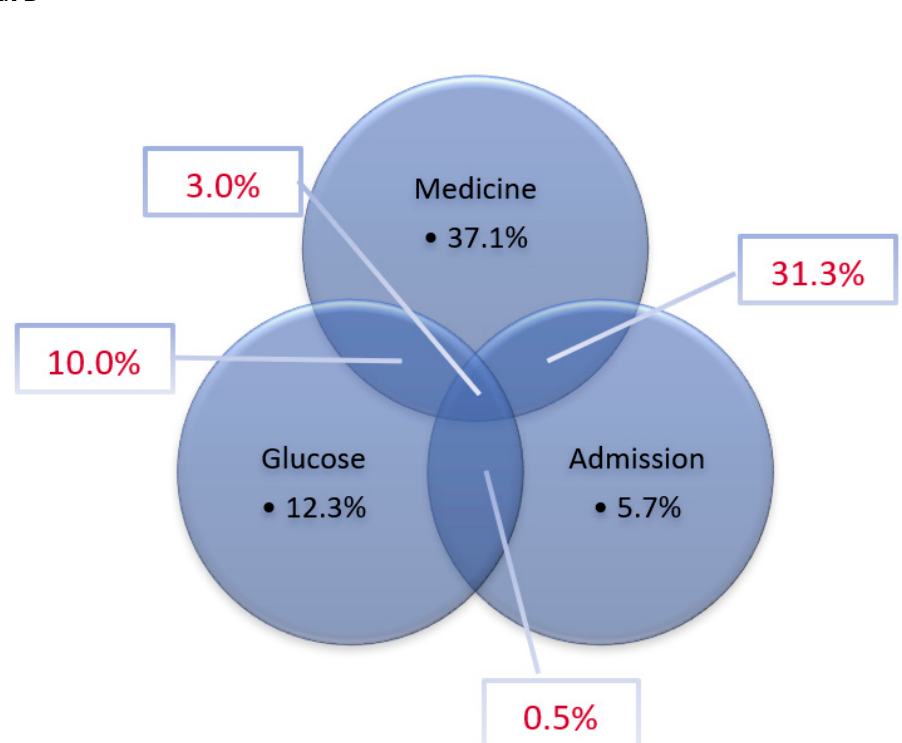
Figure A1. Venn diagram of inclusion criteria for the capital region of Denmark. Note: Figure shows the distribution of the three criteria for which the patients were included in the T2 diabetes population.